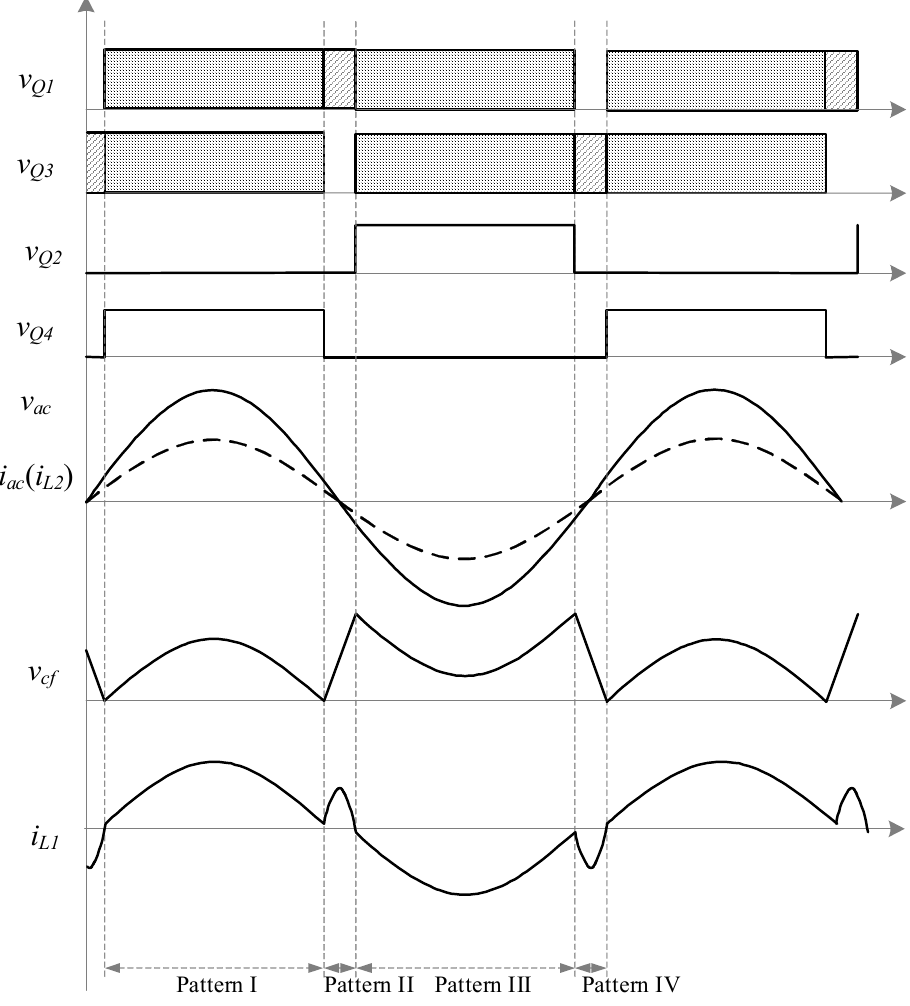
Figure 3. Steady-state waveforms of the PFC.